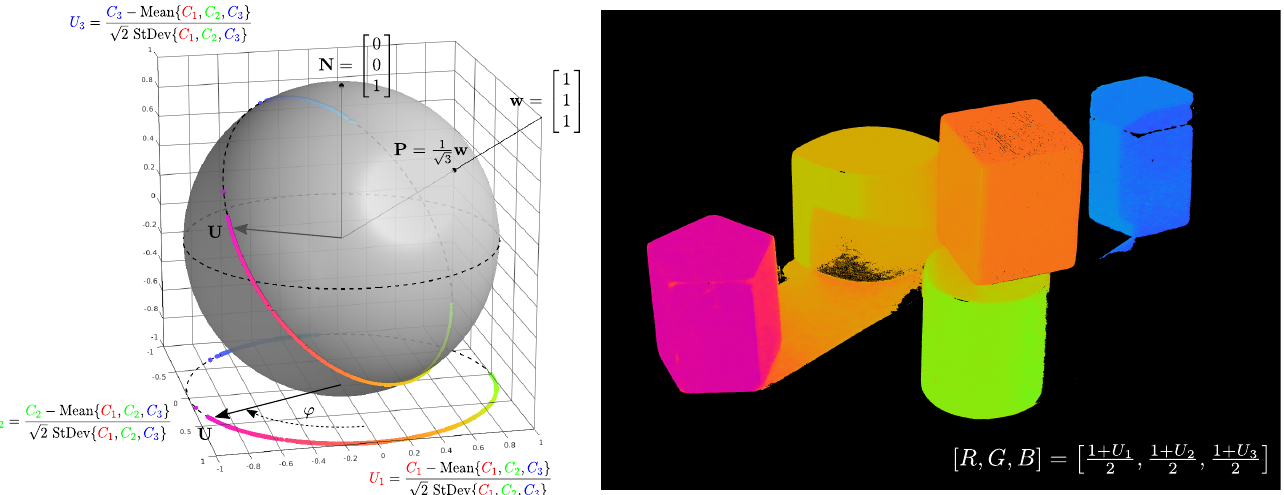
Figure 5. Illustration of multispectral hue U computed on the RGB image of Figure 3. ( Left panel ): location of transformed pixel values on a great circle in a plane orthogonal to white vector w = [ 1,1,1 ] T . ( Right panel ): transformed RGB image. This time, it is the resaturation condition that must be interpreted as a scalar